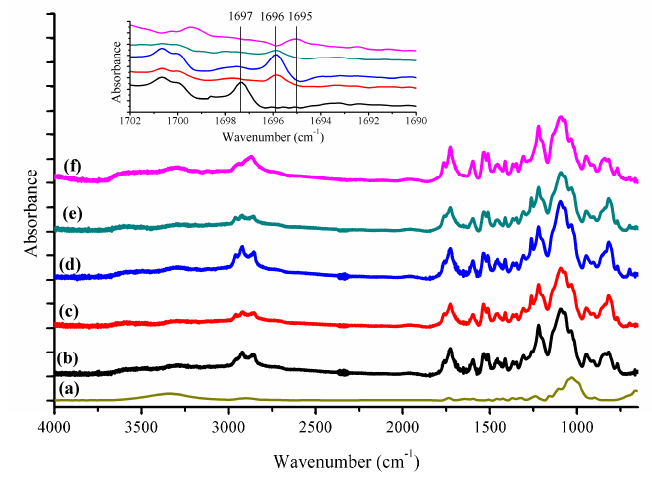
Figure 2. ATR-FTIR spectra of ( a ) RJF; ( b ) ASKLTPU30P; ( c ) RJF/ASKLTPU30 10/90; ( d ) PJF200/ASKLTPU30 10/90; ( e ) PJF250/ASKLTPU30 10/90; and ( f ) PJF300/ASKLTPU30 10/90 (inset graph: ATR-FTIR spectra in the range of 1702–1690 cm − 1 ).